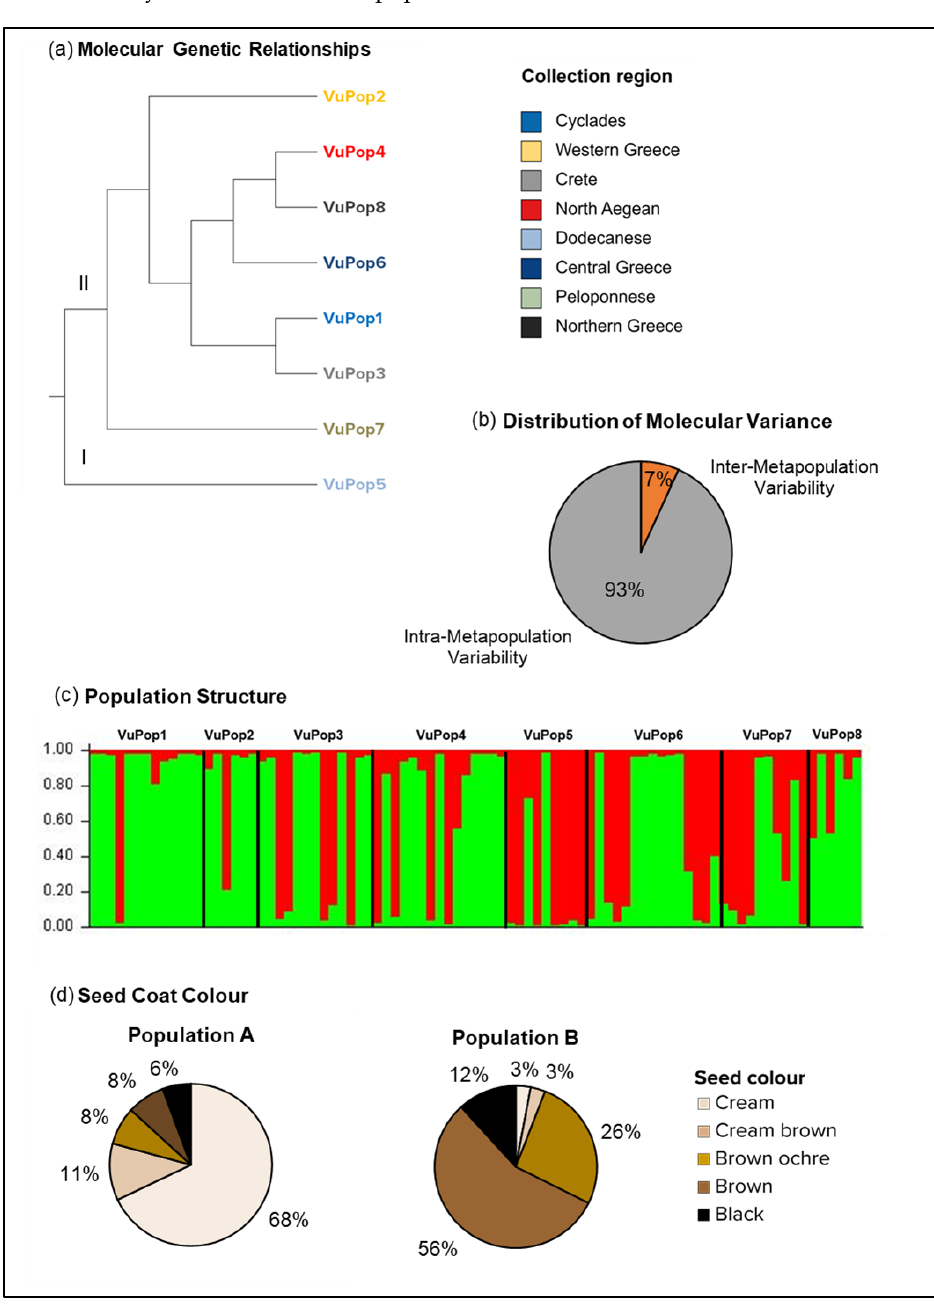
Figure 4. ( a ) SSR-generated dendrogram of the 8 cowpea metapopulations, distributing the land- races in two main clusters; ( b ) distribution of variance according to AMOVA; ( c ) population structure graph of the estimated membership of the 87 cowpea landraces, based on 14 SSR markers (K = 2), indicating the emergence of two subpopulations; and ( d ) seed coat color distribution among the two populations.